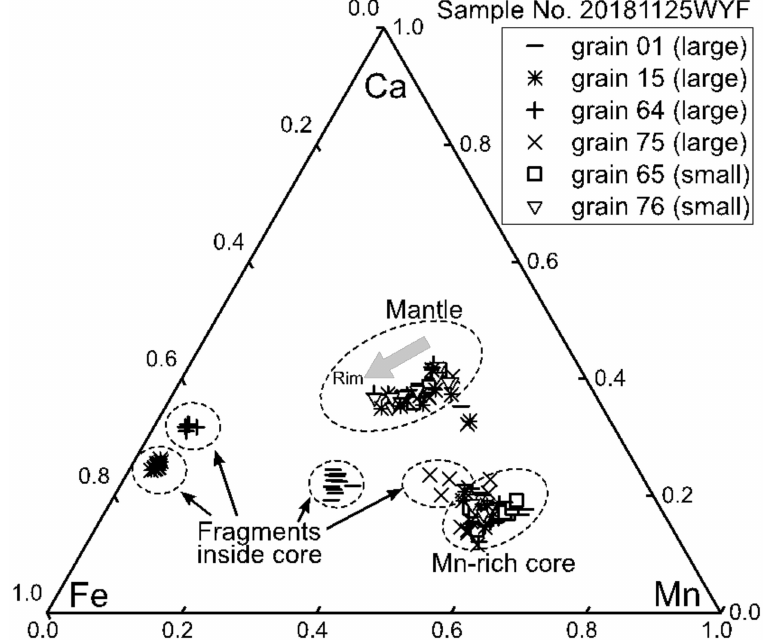
Figure 7. Triangular plot of the chemical trend of garnet grains from the core to the rim obtained from semi-quantitative analyses by EDS. All grains are from sample 20181125WYF. The chemical composition of the Mn-rich cores and the Ca-rich mantles are similar in all grains, whereas that of the Fe-rich fragments inside the Mn-rich cores in larger grains vary from grain to